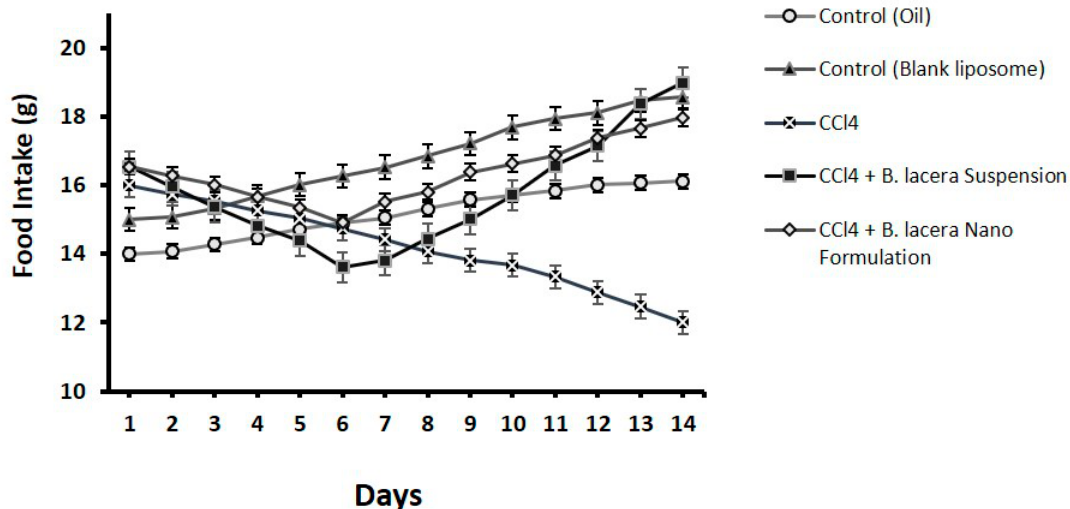
Figure 4. Effect of B. lacera leaf extract and its liposomal preparation on food intake of CCl 4 -treated rats for14 days. Data are presented as mean ± standard error of mean, where n = 6.